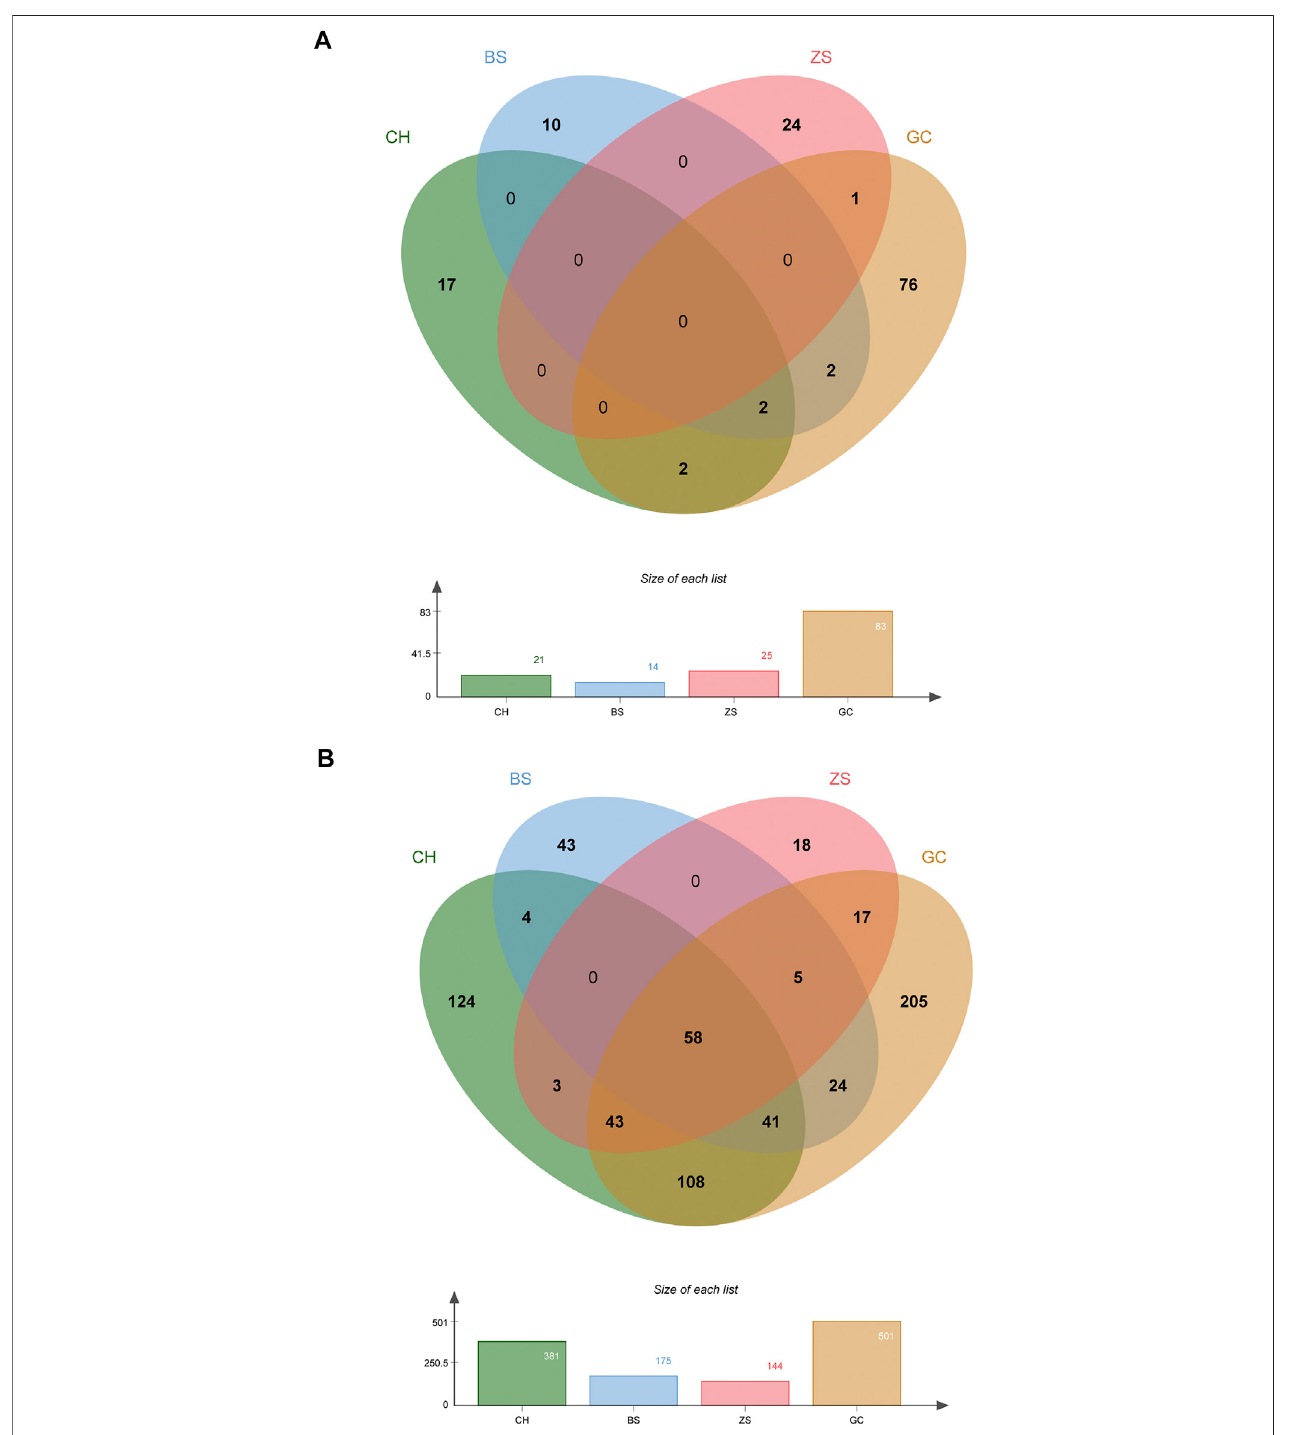
FIGURE2| ScreeningofpotentialpharmacodynamiccomponentsandtargetsofSNS. (A) Venndiagramofpotentialpharmacodynamiccomponentsineachherb of SNS. (B) Venn diagram of potential pharmacodynamic targets of each herb of SNS.